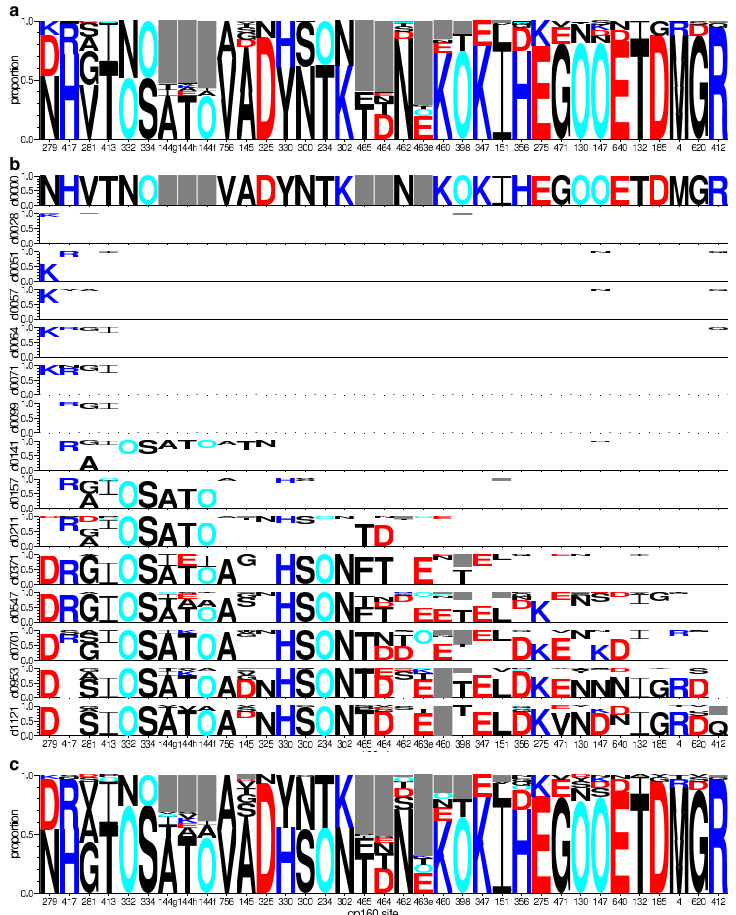
Figure 5. Variant frequency across 35 sites selected from CH505 Env gp160. (a) Population variant frequencies, computed from 385 aligned, full-length protein sequences; (b) Temporal development of variant frequencies. To emphasize TF loss progression, frequency of the TF form below the first row is blank. Each row corresponds to one time-point sampled for the three-year study period, days 0–1121 (d0000 through d1121); (c) Variant frequencies in swarm set of 54 selected Envs. Symbol height is proportional to amino acid frequency per site. Colors correspond to Figure 2. The gaps inserted to maintain the alignment appear as grey boxes to represent indels. Site order follows ranks listed in Table 1. This visualization was produced from modified sequence logos by the lassie package; see Section 4.4 for